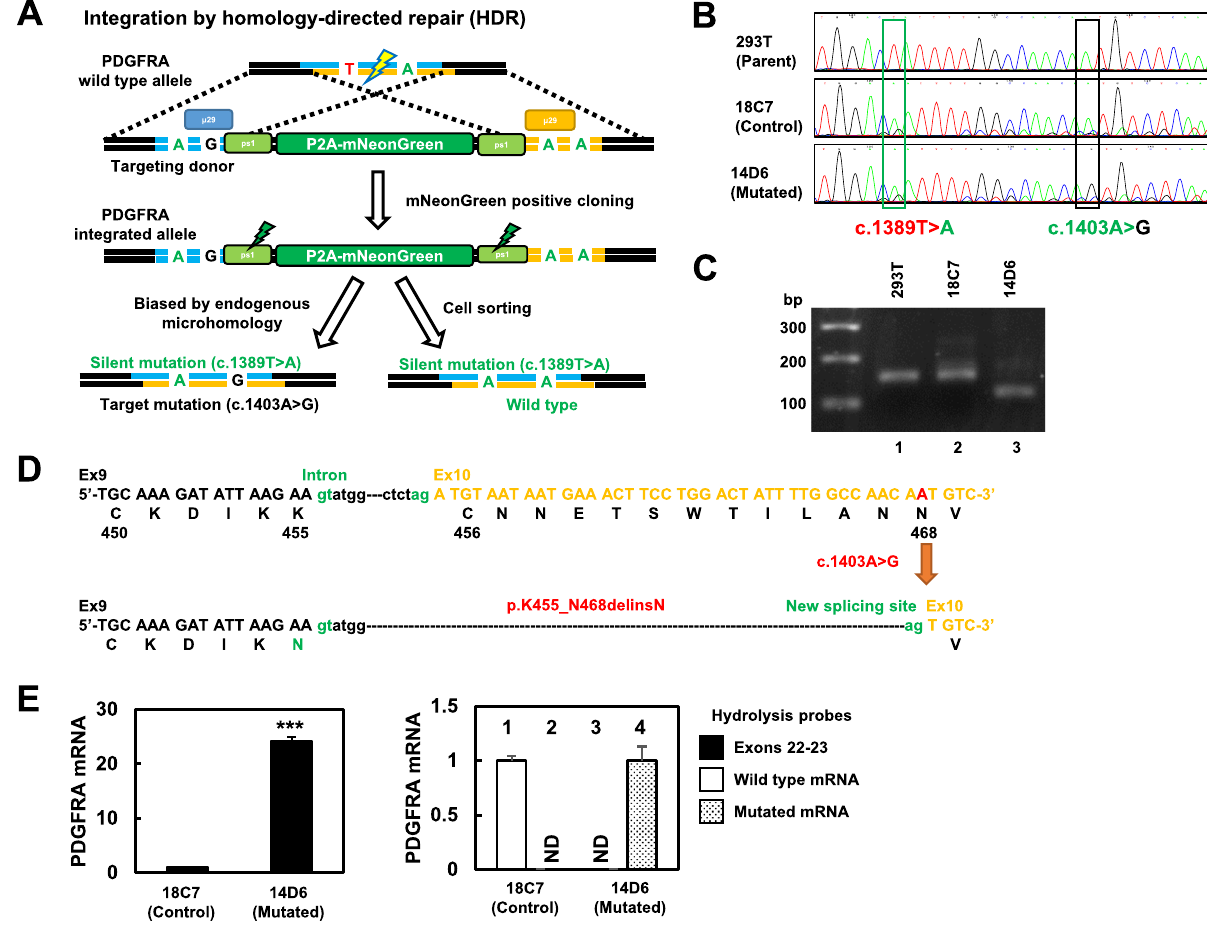
Figure 2. Schematic presentation of the genome editing strategy used in this study and effects of the PDGFRA c.1403A > G mutation. (A) A scheme representing the approach used for the generation of c.1403A > G PDGFRA -mutated HEK293T cells. Arrows indicate the primers designed to amplify the predicted insertion site with (product size: 1091 bp) and without (product size: 149 bp) the selection cassette. The figure is drawn using Microsoft PowerPoint 2019 MSO (https:// suppo rt. office. com/ ja- jp/ artic le/ Office). ( B) Sanger sequencing of the edited clones after selection. Sequencing of the 14D6 clone showed both the targeted (c.1403A > G) and silent (c.1389 T > A) mutations. Sequencing of the 18C7 clone showed only the silent mutation. ( C) Agarose gel analysis of PDGFRA mRNA expression using RT-PCR in the established clones. The size of the PCR products from the 14D6 clone was smaller than those from parental HEK293T and 18C7 isogenic control cells. ( D) Schematic presentation of the c.1406A > G PDGFRA -associated new splicing site leading to the deletion of 39 nucleotides (13 amino acids). ( E) PDGFRA mRNA expression analysis by qRT-PCR (n = 6 per group). Left panel: in qRT-PCR recognizing exons 22 to 23, the 14D6 clone exhibited an increase in mRNA expression compared to that in the 18C7 isogenic control clone. Right panel: using probes for the detection of the splicing mutation (lanes 2 and 4) and wild-type (lanes 1 and 3) sequences, mutated cDNA was amplified only in the 14D6 clone (lane 4), whereas wild-type cDNA was only detected in the 18C7 clone (lane 1). GAPDH was used as the reference gene for quantification and the data were shown in fold changes of expression. ***, p < 0.001; ND, Not detected. For uncropped gel source of (C) , see Supplemental Fig.